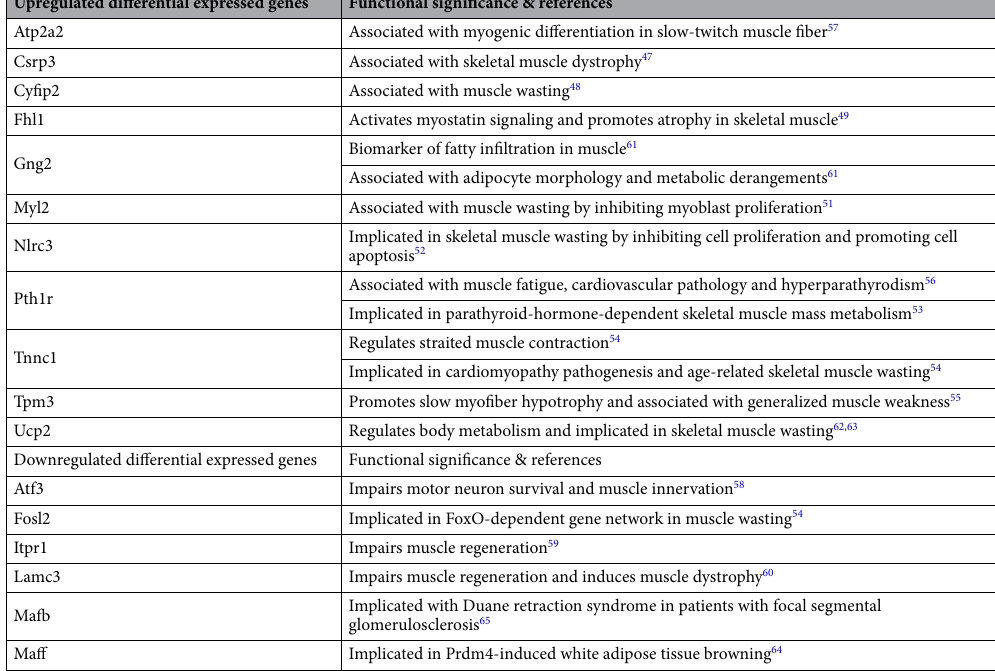
Table 1. Anakinra normalizes or attenuates expression of important muscle genes that have been implicated in muscle wasting in CKD mice. Previously, we studied differential expression of gastrocnemius mRNA between 12-month-old WT/CKD mice and WT/Sham mice using RNAseq analysis 12 . We focus on pathways related to energy metabolism, skeletal and muscular system development and function, nervous system development and function as well as organismal injury and abnormalities. For this study, WT/CKD and WT/ Sham mice were treated with anakinra or vehicle for 6 weeks and mice were sacrificed at 14-weeks of age. We studied the effects of anakinra on skeletal muscle and energy homeostasis in CKD mice by extrapolating the top 20 differentially expressed muscle genes identified in our previous investigation. Importantly, anakinra normalized (Atf3, Atp2a2, Fhl1, Fosl2, Gng2, Itpr1, Lamc3, Mafb, Maff, Myl2, Nlrc3, Pth1r, Tnnc1, Tpm3, Ucp2) and attenuated (Csrp3), Cyfip2) muscle gene expression in WT/CKD mice relative to WT sham mice. Functional significance of each of these 17 differentially expressed muscle genes is